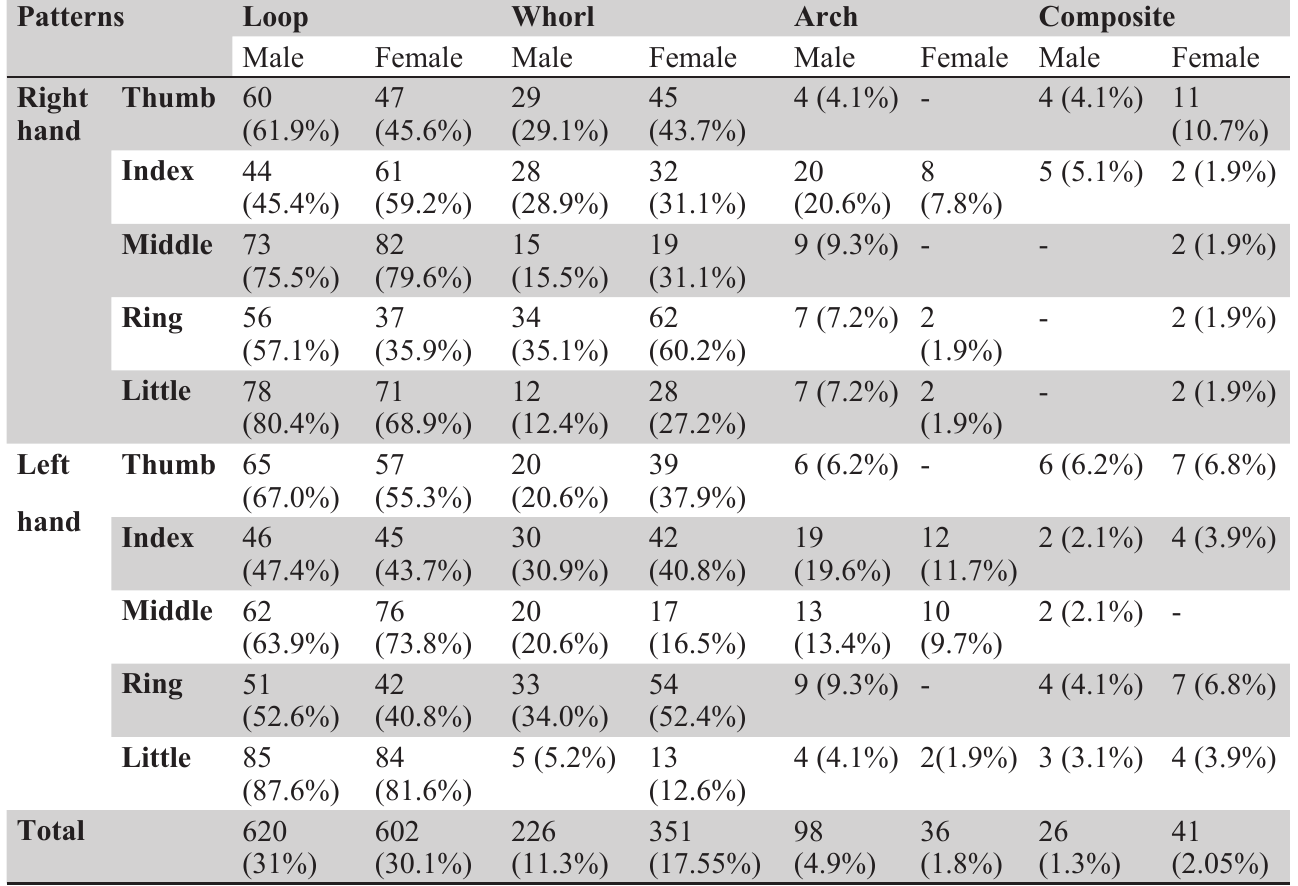
Table 1: Distribution of fingerprint patterns in males and females.